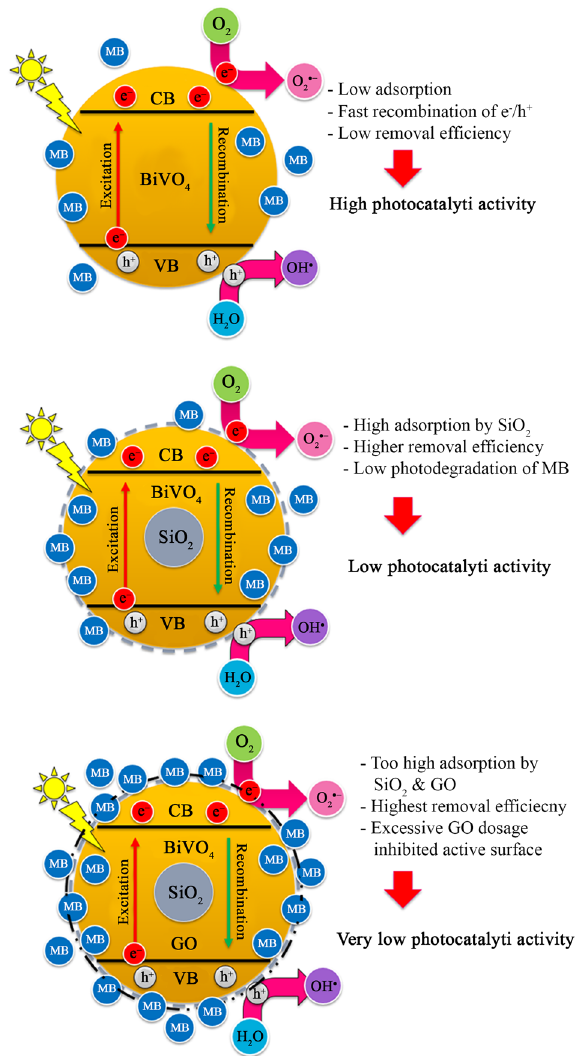
Figure 5. Summary of photodegradation of MB over BiVO 4 , BiVO4/SiO 2 and BiVO 4 /SiO 2 /GO.